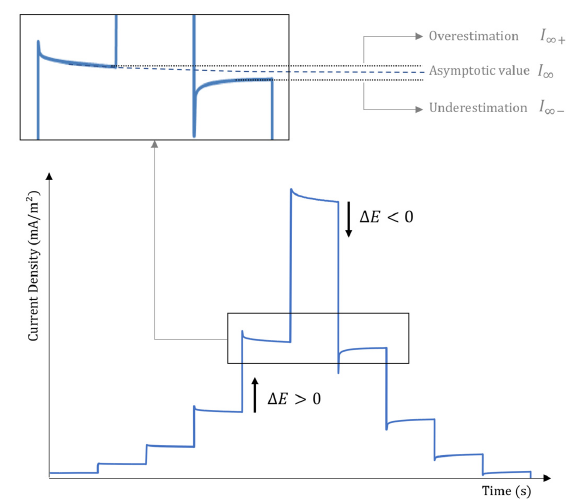
Figure 6. Illustration of the reversible potentiostatic step